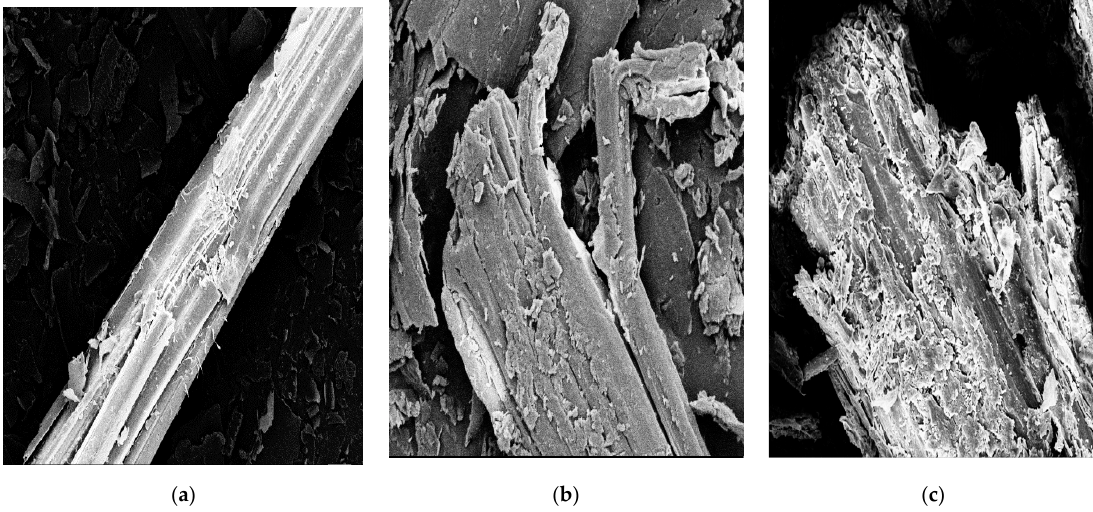
Figure 4. SEM images (at a 500 magnification) of untreated straw and the pretreatment samples by distilled water and FeCl 2 at 180 °C and 10 min. ( a ) untreated corn straw; ( b ) pretreated with distilled water; ( c ) pretreated with 1 × 10 − 5 mol/L FeCl 2 .